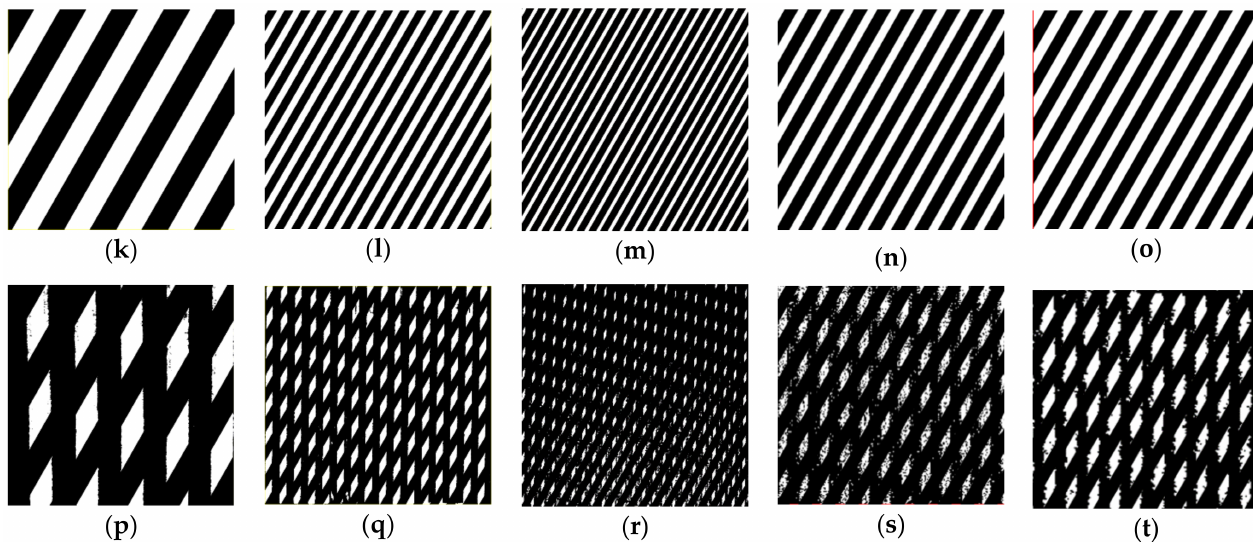
Figure 4. Captured intensities on the screen for test samples (TSs): ( a ) TS1, ( b ) TS2, ( c ) TS3, ( d ) TS4, and ( e ) TS5. Gray-level transformed images of the captured intensity for the TSs: ( f ) TS1, ( g ) TS2, ( h ) TS3, ( i ) TS4, and ( j ) TS5. Digital gratings with a slant angle of 30 ◦ for TSs: ( k ) TS1, ( l ) TS2, ( m ) TS3, ( n ) TS4, and ( o ) TS5. Moir é patterns obtained with digital image post processing of the TSs: ( p ) TS1, ( q ) TS2, ( r ) TS3, ( s ) TS4, and ( t ) TS5. Table 1. Relevant parameters, experimental results, and percent errors for focal length and radius of curvature measurement.